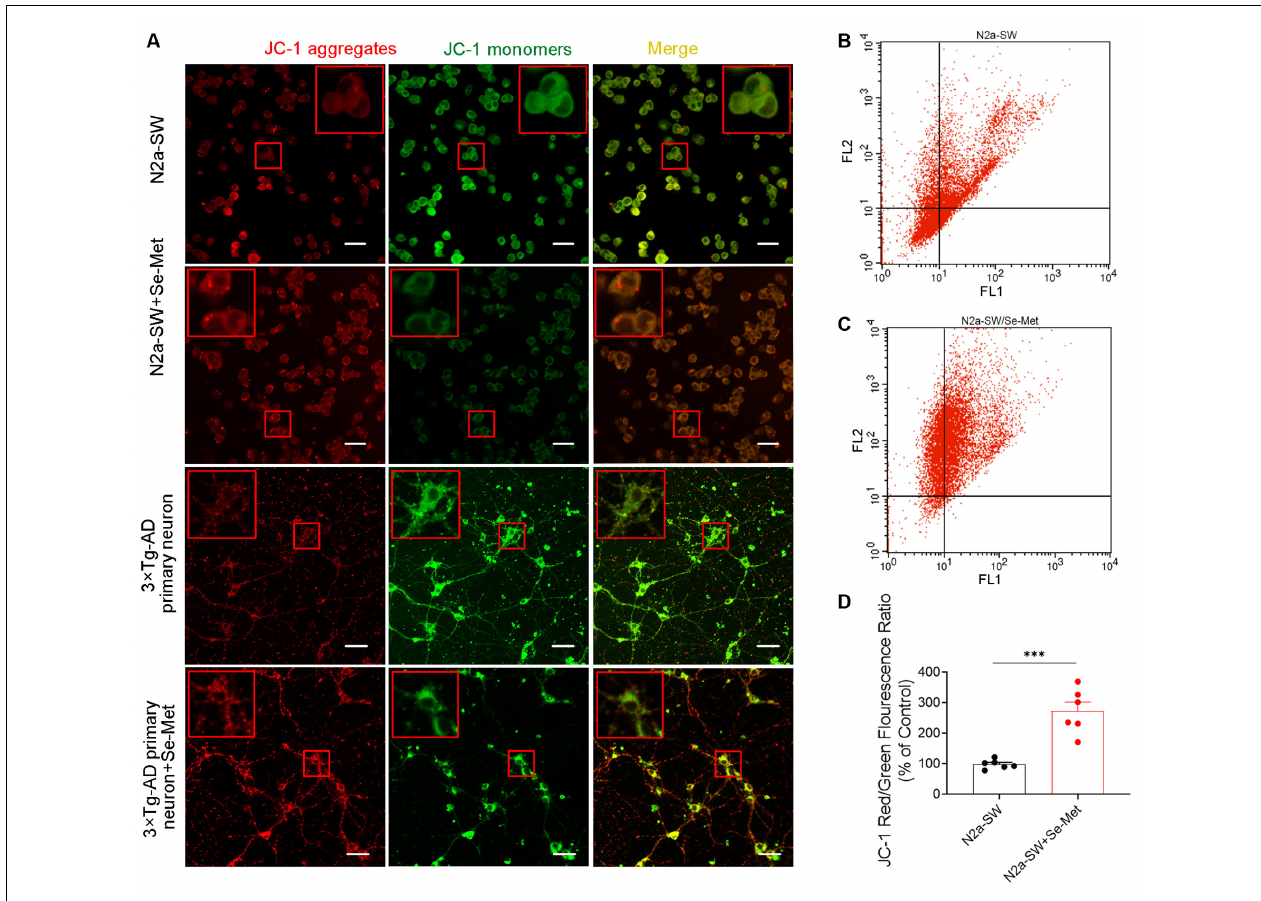
FIGURE 6 | Effect of Se-Met on MMP as detected by JC-1 staining. (A) Confocal images showing the MMP measured using JC-1 as a probe. Scale bar, 10 µ m. (B–D) Flow cytometry-based quantitative analysis of JC-1 in N2a-SW cells ( ∗∗∗ p < 0.001, n =